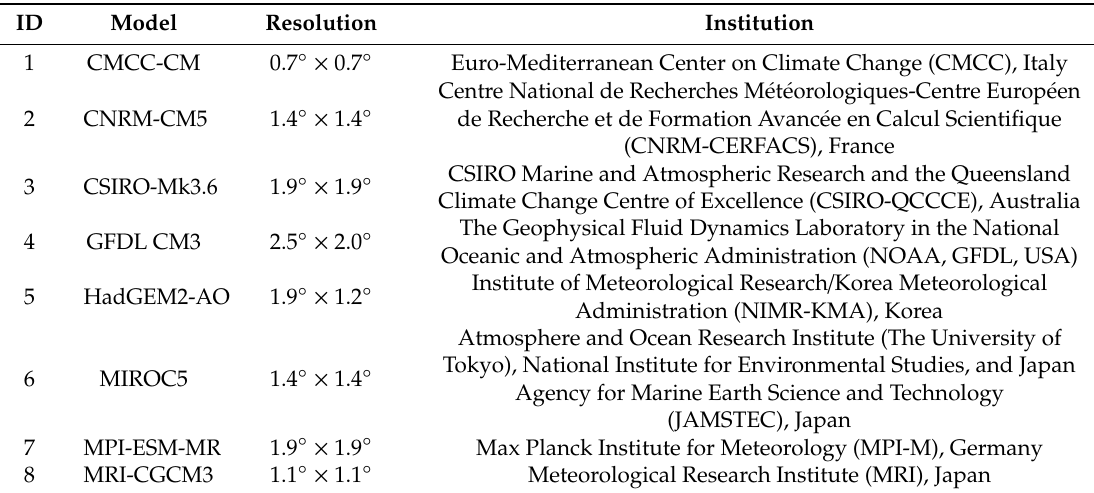
Table 2. The CMIP5 GCMs used in this